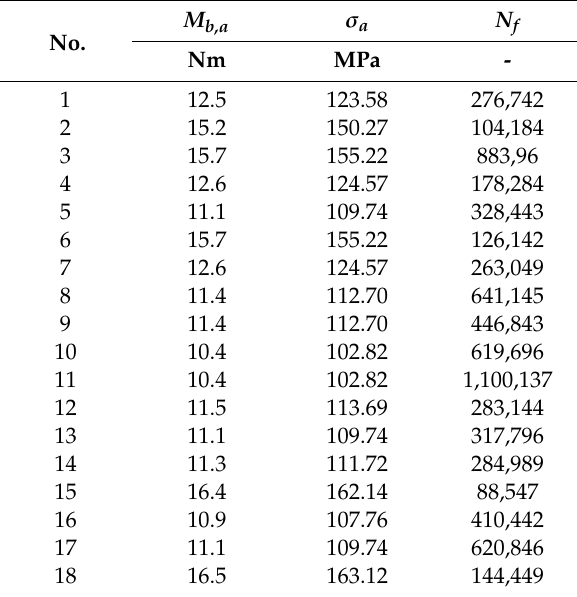
Table 5. Results of fatigue tests of samples after 14 days of immersion in a 3.5% NaCl solution in tap water.